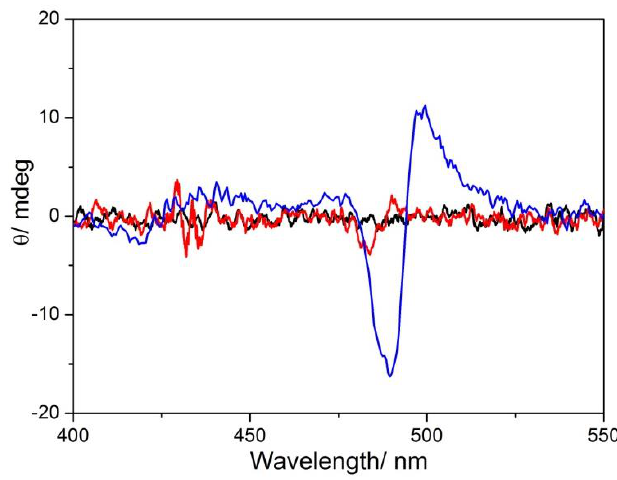
Figure 7. CD spectra of MWCNT-EPA (black line), soon after TPPS addition (red line), and 1 day after mixing (blue line). Experimental conditions: [TPPS] = 5 µ M; MWCNT-EPA = 0.02 mg / mL; 10 mM citrate bu ff er at pH 2.4; PL protocol; T = 298